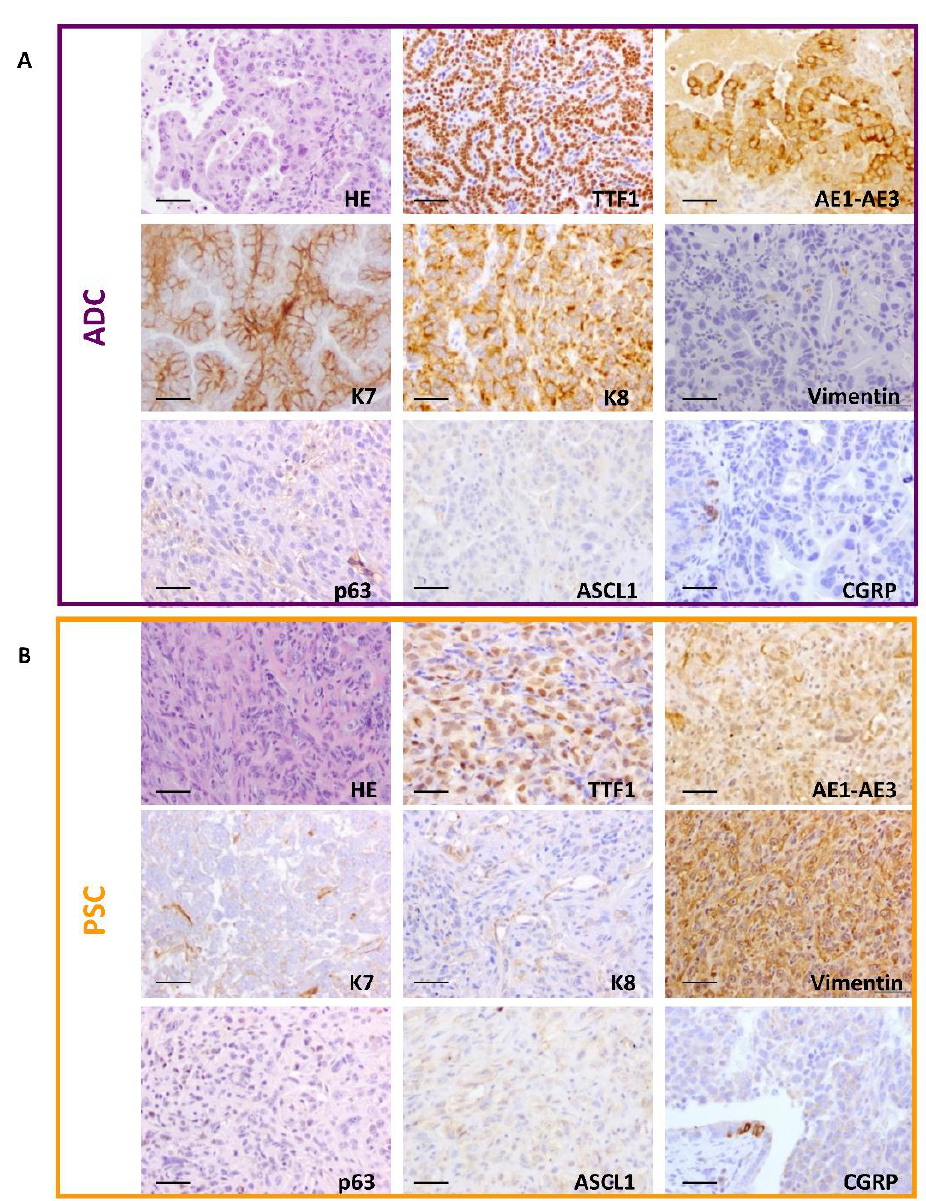
Figure 2. Adenocarcinoma and pulmonary sarcomatoid carcinoma developed in double-deficient lungs. Representative hematoxylin eosin staining of ADC ( A ) and PSC ( B ) lung tumors of DKO mice. Immunohistochemical analysis of lung tumors with the quoted antibodies. Mouse ADCs were positive for thyroid transcription factor-1 (TTF-1), keratin K7 and K8 and pan cytokeratin AE1 – AE3, and negative for vimentin. PSCs showed positive immunostaining for TTF-1 and vimentin, weak signal for AE1 – AE3 and negative staining for keratin K7 and K8. Tumors were negative for the epithelial marker p63 and the neuroendocrine markers ASCL1 and CGRP. Bars = 50 µm. Deletion of both Pten F/F and Trp53 F/F alleles in these tumors was observed by PCR (Fig-